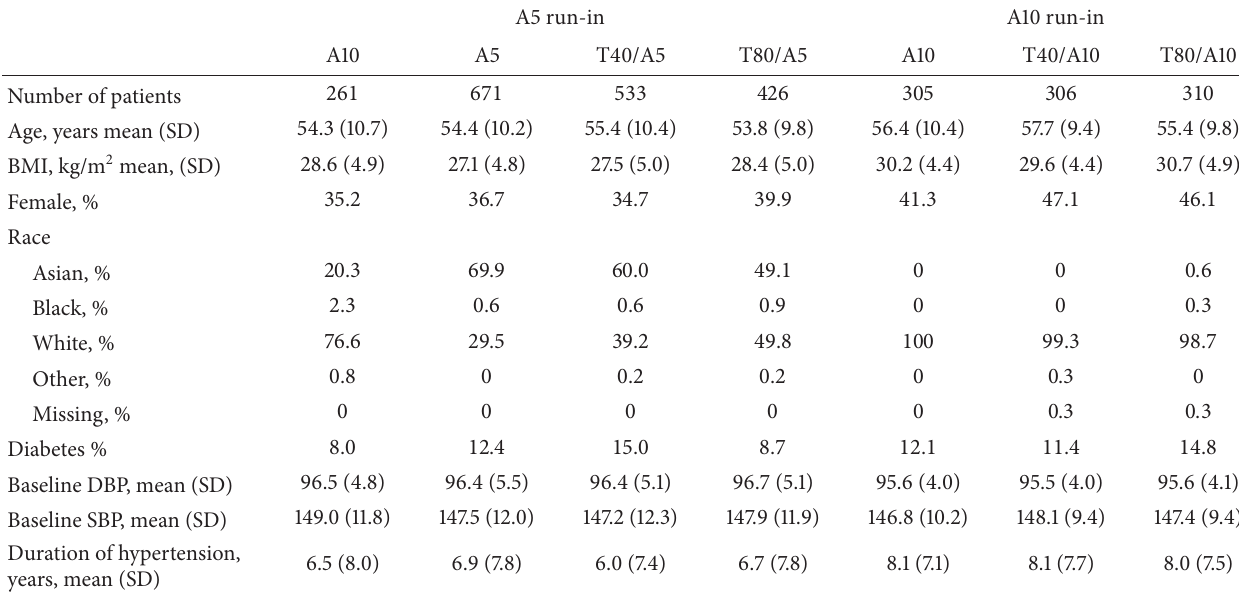
Table 2: Demographic and baseline